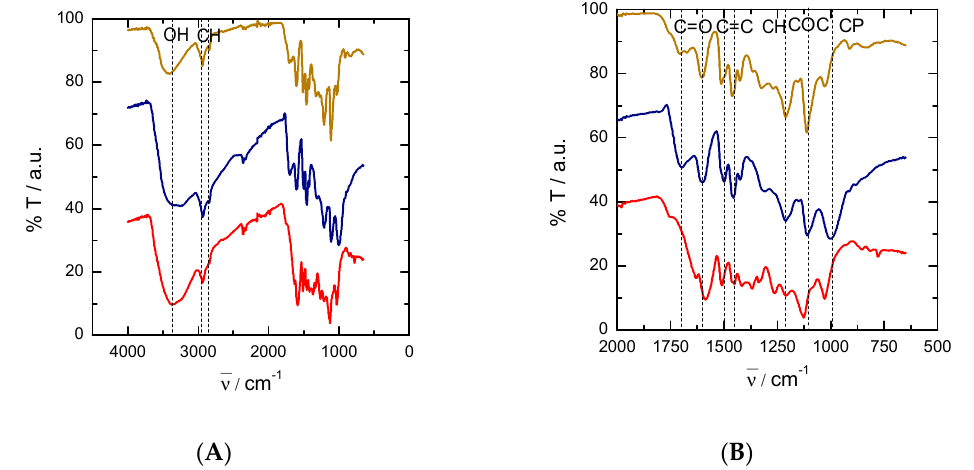
Figure 1. Fourier-transform infrared spectroscopy (FTIR) spectra of the three types of lignin: ethanol organosolv lignin (EOL, brown, top), phosphoric acid lignin (PL, blue, middle), and kraft lignin (KL, red, bottom). ( A ) General spectra; ( B ) Region from 500 to 2000 cm − 1 .